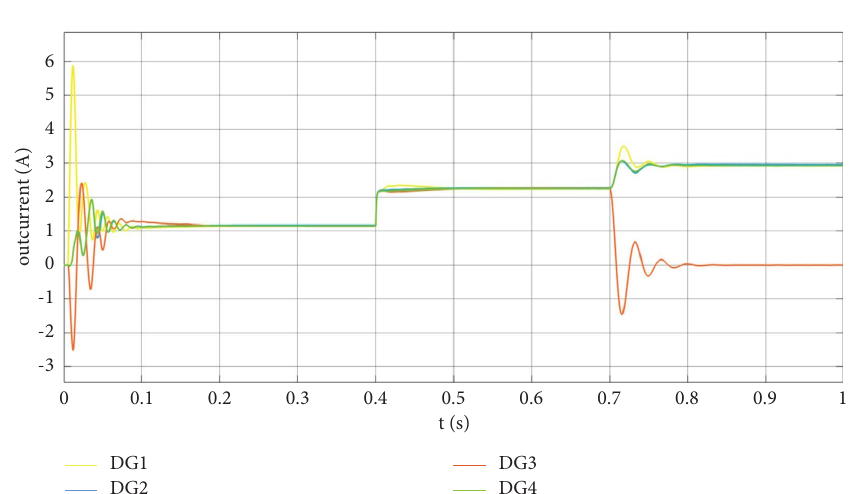
Figure 16: Output current with the proposed